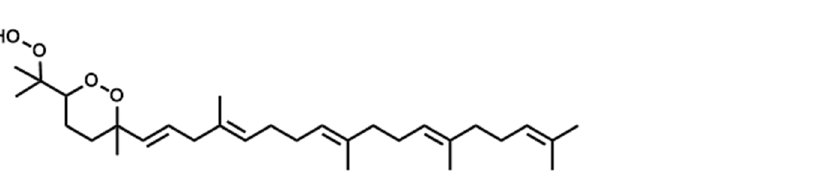
Figure 4. Candidate structures of SQ secondary oxidation product and their heteronuclear single quantum coherence (HMBC) correlations. ( 1A , 1B ), based on the correlations of H1 and H25 to C3, and H3 to C1, C2 and C25; ( 2A , 2B ), based on the correlations of H1 and H25 to C4, and H4 to C1, C2 and C25. Figure 5. Chemical structure of the newly identified SQ secondary oxidation product, 2 ‐ OOH ‐ 3 ‐ (1,2 ‐ dioxane) ‐ SQ. Table 1. Results of the 13 C chemical shifts calculations carried out on Spartan 18 software.